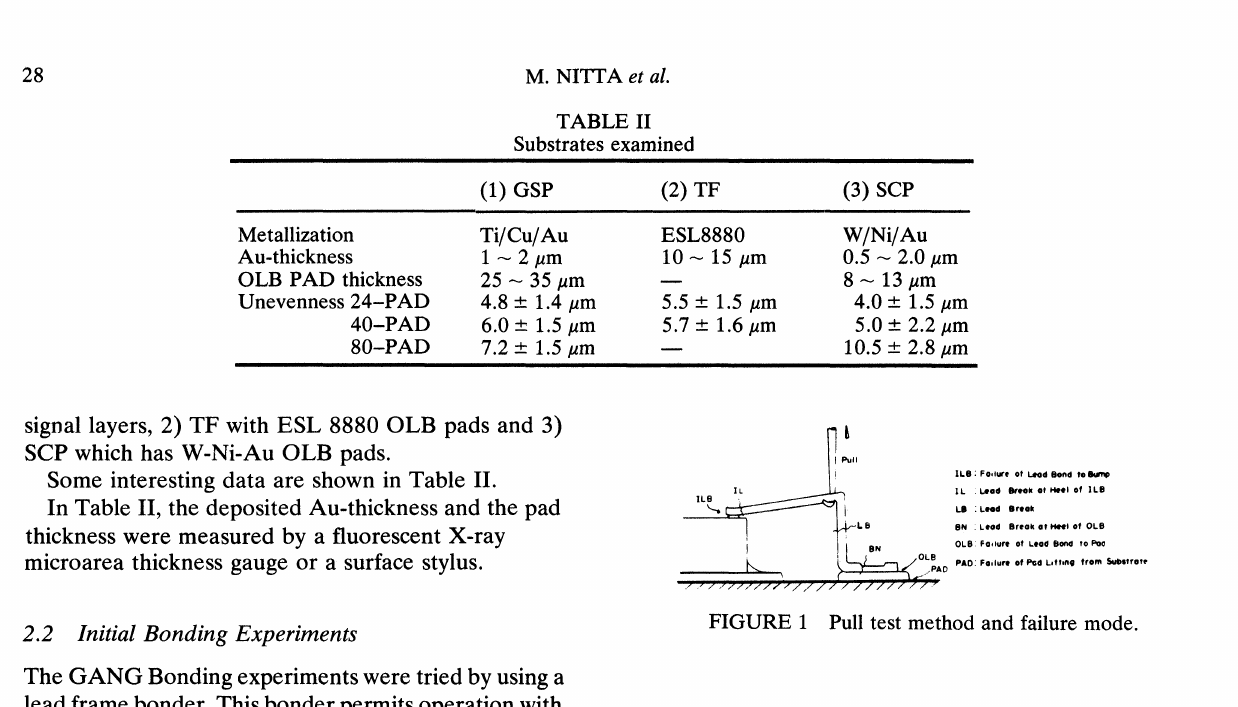
Pull test method and failure